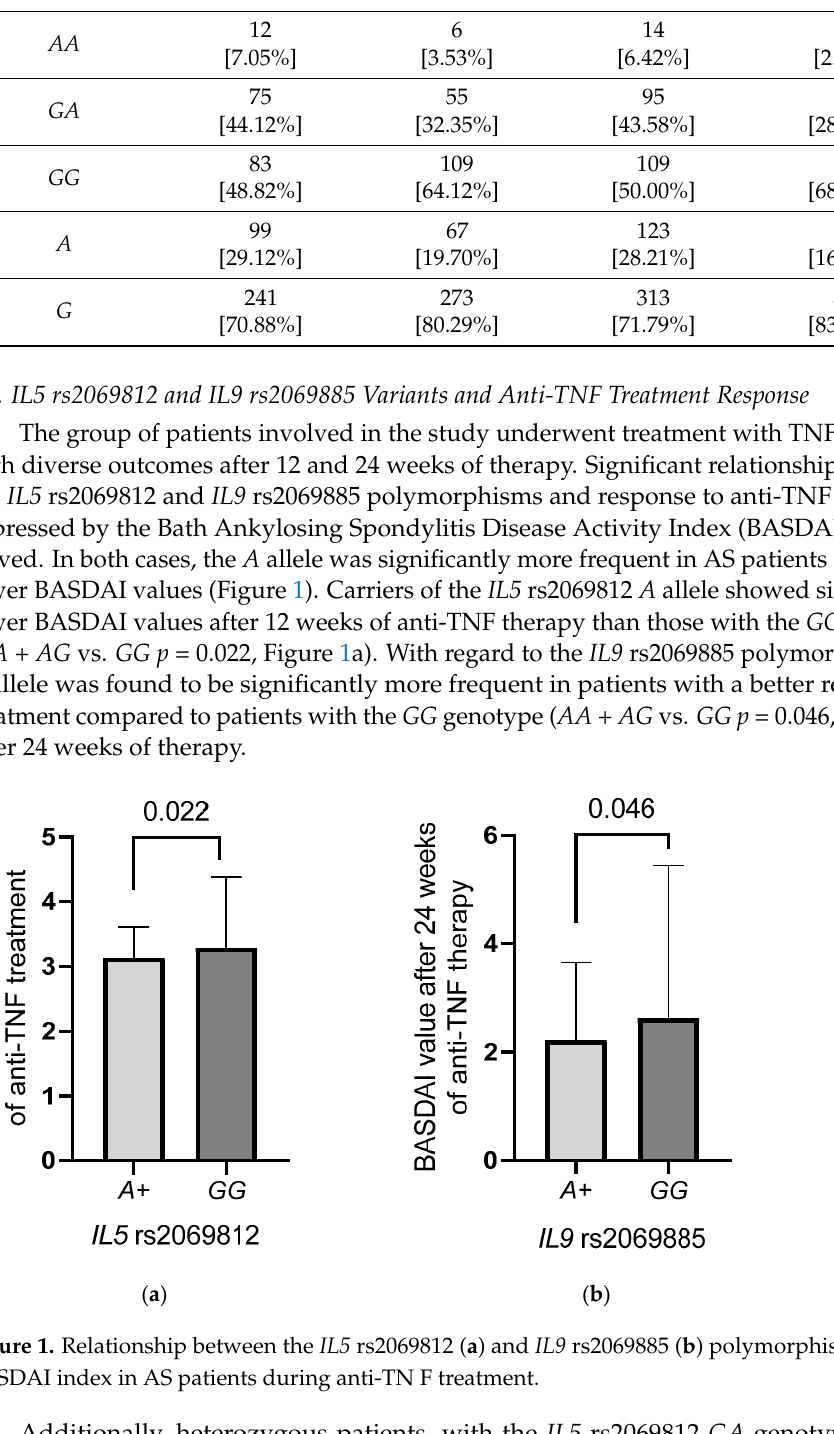
were no significant differences either in the frequency of alleles and genotypes between AS patients and control groups or in the stratified analyses with respect to gender. Table 1. Distribution of the IL5 rs2069812 or for IL9 rs2069885 alleles and genotypes in AS patients. AS Patients Controls N = 170 N = 218 IL5 IL9 Allele/Genotype rs2069812 AA GA 75 [44.12%] [32.35%] GG